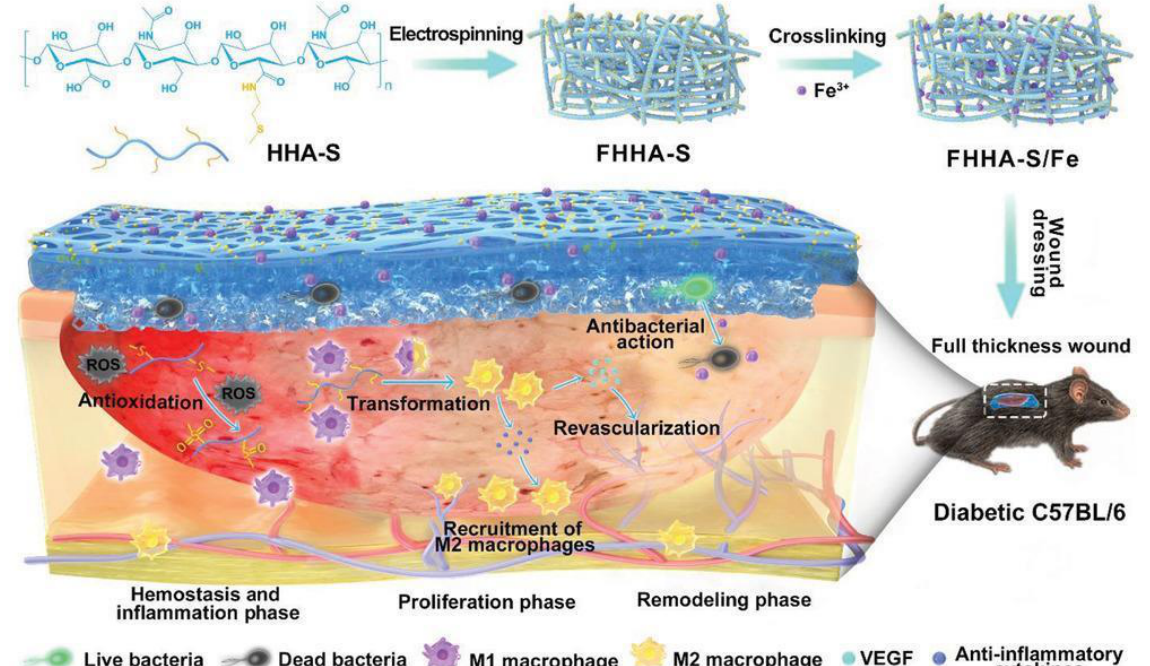
Figure 4. Schematic illustration of the absorbable thioether grafted hyaluronic acid nanofibrous hydrogel for synergistic modulation of the inflammation microenvironment to accelerate chronic diabetic wound healing. Illustration of the preparation procedure of FHHA-S/Fe, dressing of FHHA- S/Fe on full-thickness wound model in diabetic C57BL/6 mouse, and the mechanism of FHHA-S/Fe for enhanced chronic wound healing effect. Copyright Wiley-VCH Verlag GmbH. Reprinted with permission from [82].